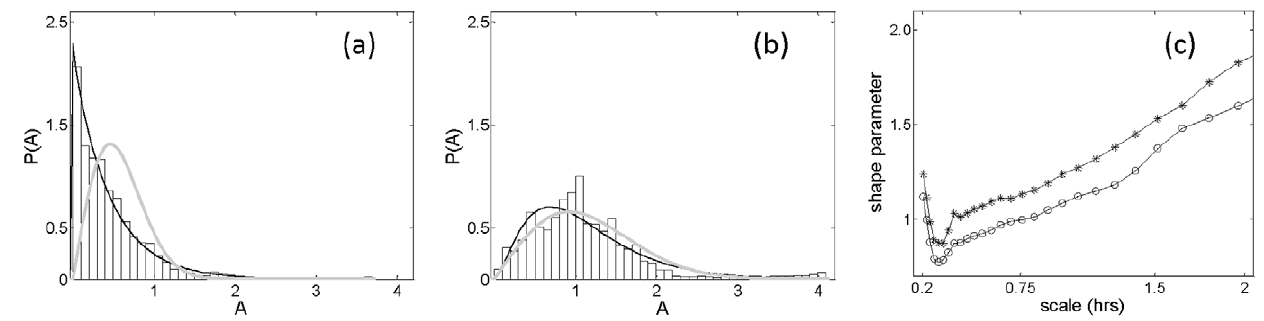
Figure 3. Characterization of the probability distribution of amplitudes using Gamma and Rayleigh functions. ( a ) Probability distribution P(A) for a subject considered to be a low risk for BD at a scale s , 0.59 h, along with Gamma (black line) and Rayleigh (grey line) best-fit functions: based on AIC, the Gamma distribution yields a better fit. ( b ) Probability distribution P(A) at a scale of s , 3.0 h for the same subject: the fit of the Rayleigh distribution function (gray line) is superior to the Gamma function at this scale, by AIC criteria. ( c ) Average value of the shape parameter, c , at different scales (hours) for 35 subjects considered to be low risk for BD by GBI criteria (open circles) and another 35 at high risk (filled circles).